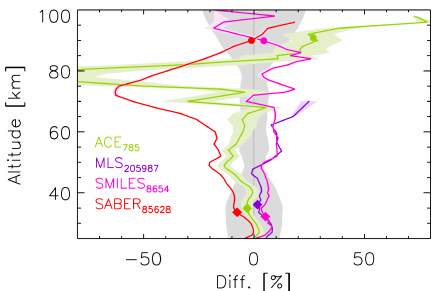
Figure 10. As Fig. 9 but for nighttime O 3 . Instrument colours are the same except that ACE-FTS is replaced by GOMOS (light